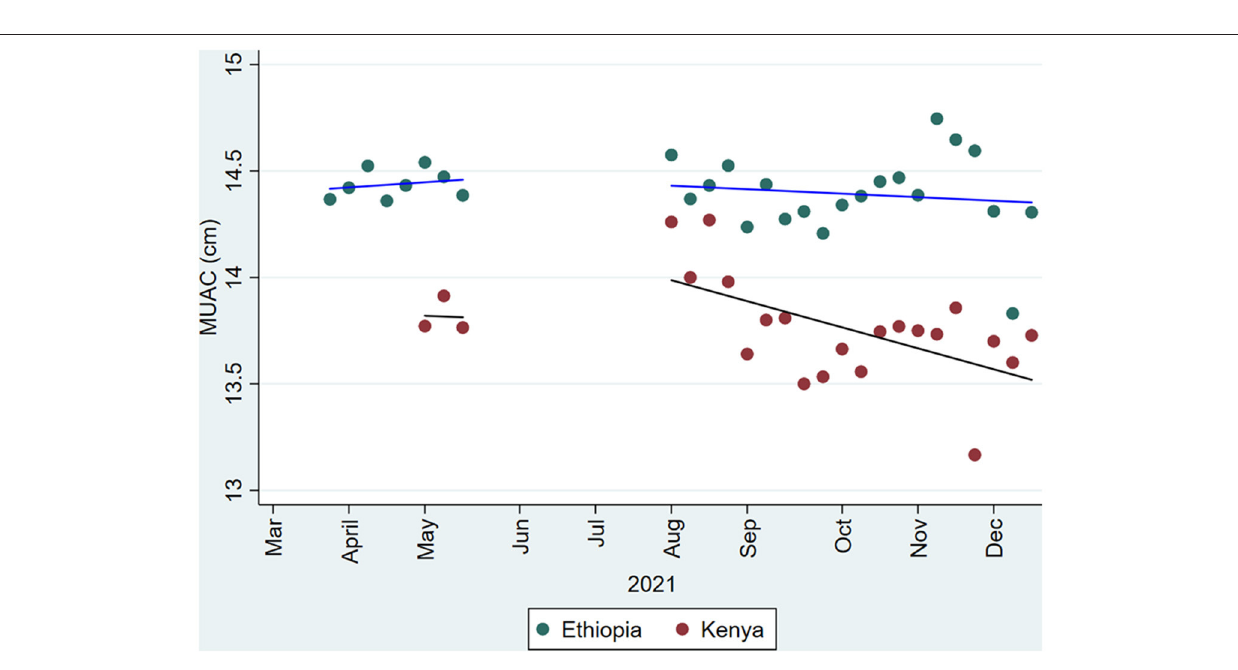
FIGURE 7 | MUAC measurement of the youngest child in the